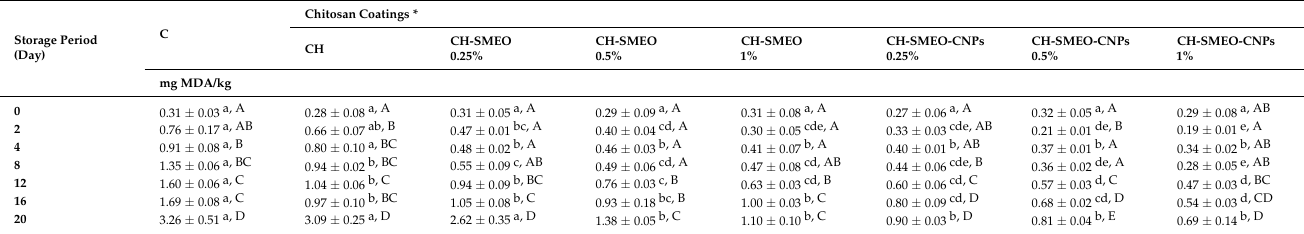
Table 8. Malonaldehyde (MDA) content in beef samples treated with chitosan coatings and chitosan- based nanoparticles enriched with Satureja montana L. essential oil during